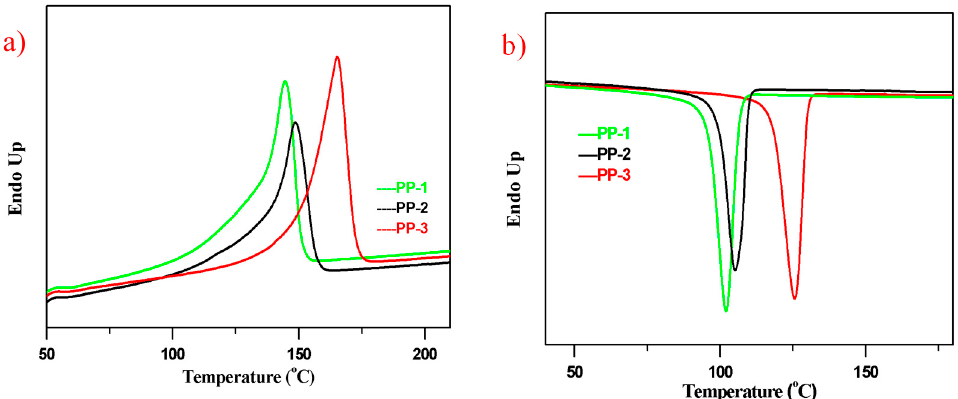
Figure 5. DSC curves for thee PP pellets at 20 ◦ C / min. ( a ) Melting curves; ( b ) cooling curves.